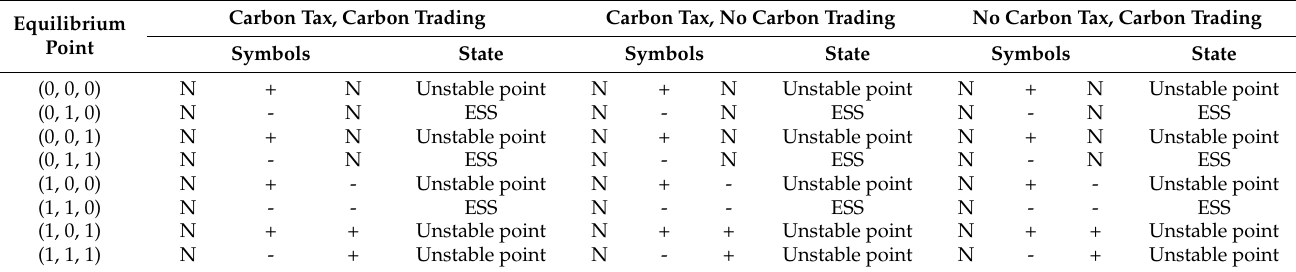
Table 4. Stability of each equilibrium point under the three